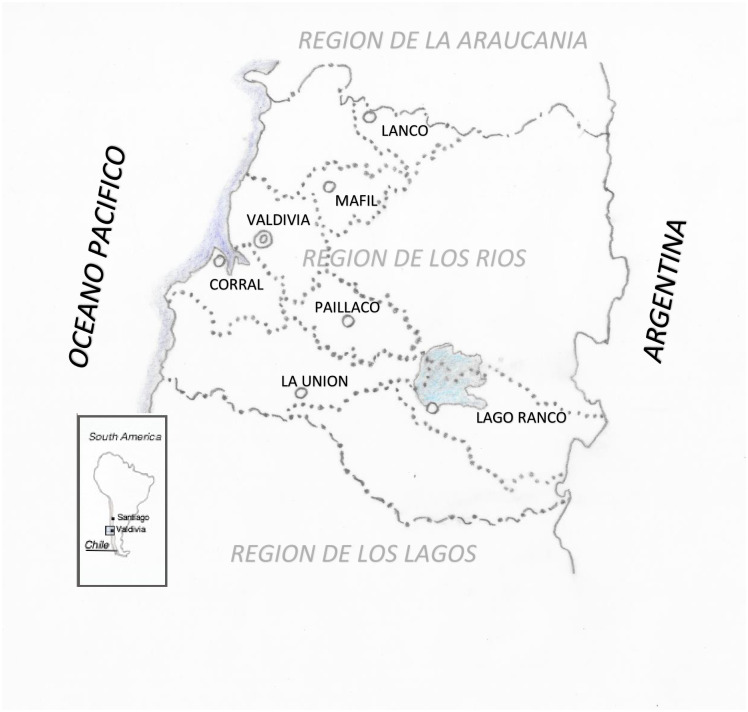
Map of Latin America and of the region Los Rios in Southern Chile.Sampled cats originated from the 7 delineated municipal districts.